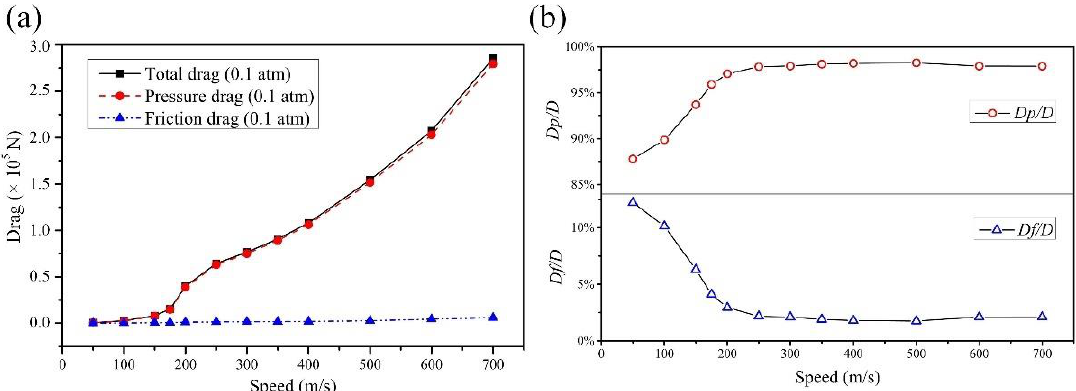
Figure 10. ( a ) Relationship between the drag and travelling speed of the tube train at 0.1 atm, ( b ) percent of pressure drag to total drag and percent of friction drag to total drag at 0.1 atm.